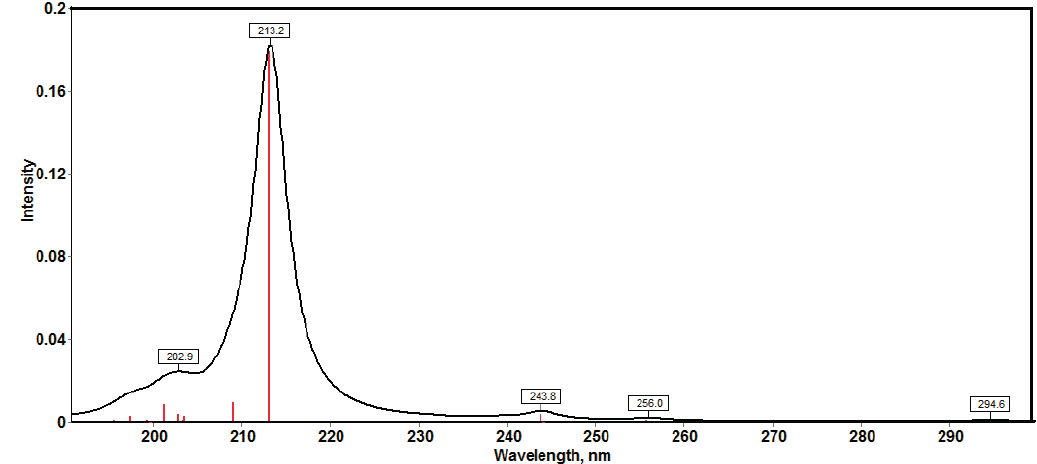
Figure 8. The calculated electronic spectra of the studied compound using the TD-DFT